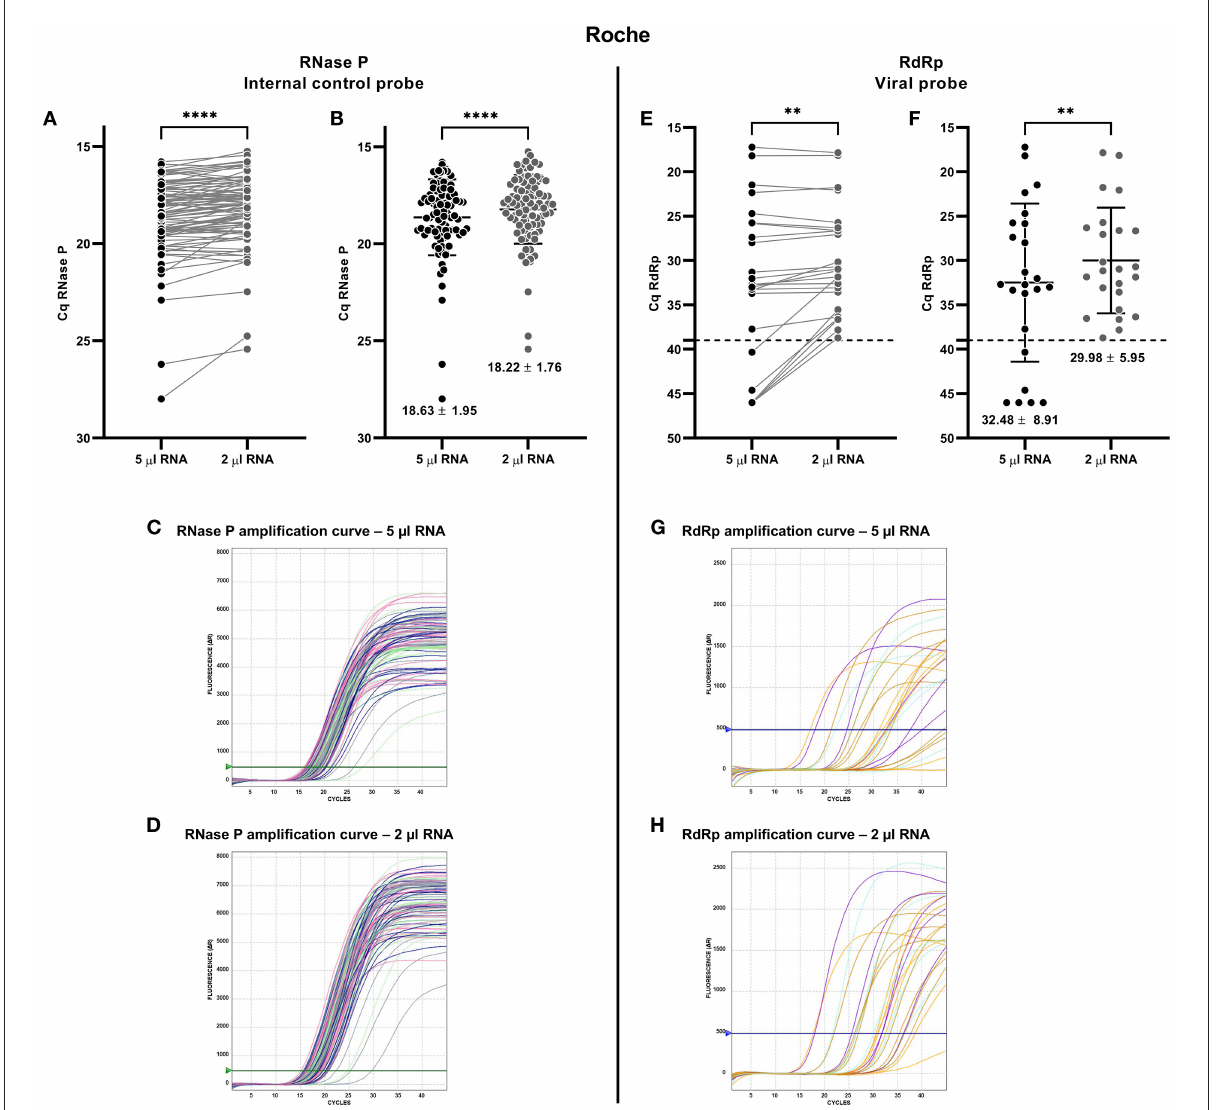
FIGURE3 Comparative analysis for detecting SARS-CoV-2 from nasopharyngeal swab (NPS) samples using RNase P and RdRp gene probes from Roche RT-qPCR kit. The comparison was made from the same NPS sample loading the recommended volume of extracted RNA (5 µ l of total RNA, recommended by the manufacturer; black spots) and 2 µ l of total RNA (gray spots). Each spot is an analyzed sample for each volume condition (5 µ l; 2 µ l). For graphs (A,E) , the line connecting the points shows the paired results obtained from the same sample analyzed by loading the two different volumes. Cq = 46 denotes no amplification (No Cq). (A) Paired quantification cycle (Cq) analysis for RNase P probe of each sample assessed. (B) Cq means value (mean ± SD) for the RNase P probe amplification. RNase P probe amplification curves loading (C) 5 µ l and (D) 2 µ l of total RNA. (E) Paired Cq analysis for RdRp probe of each sample assessed. (F) Cq means value (mean ± SD) for the RdRp probe amplification. The broken line indicates the Cq cut-off value (Cq ≤ 39) recommended by the manufacturer. RdRp probe amplification curves loading (G) 5 µ l